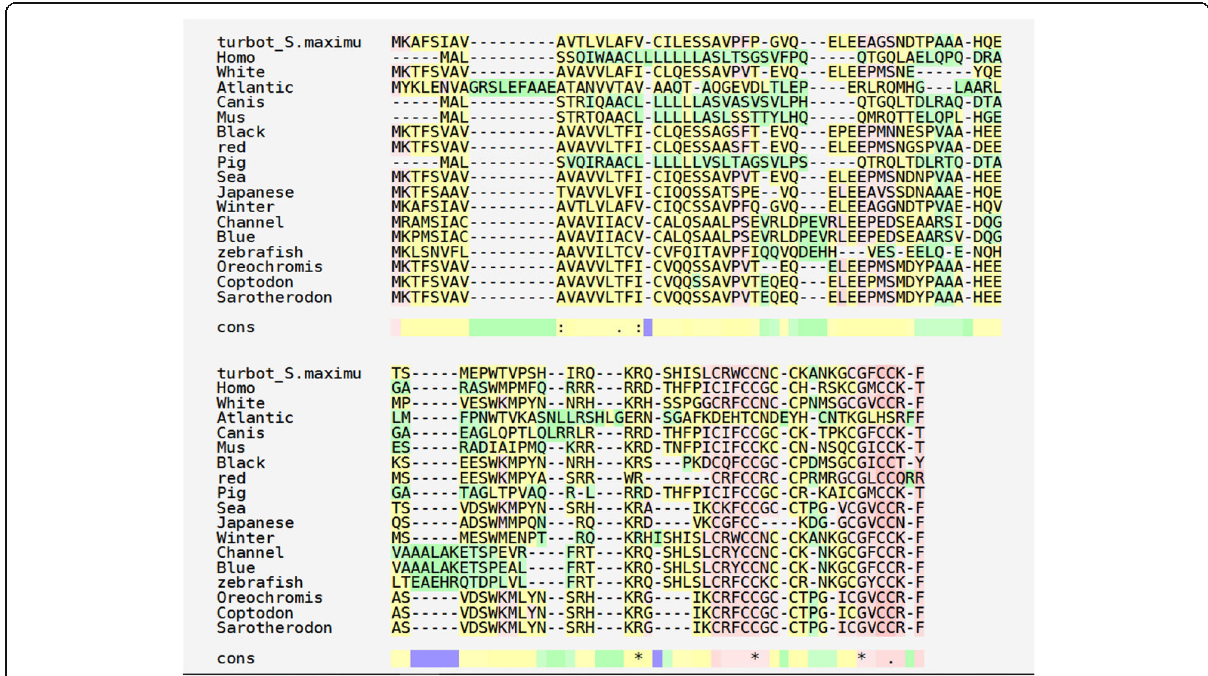
Fig. 4 Alignment of deduced amino acid sequences of O. niloticus , T. zillii , and S. galilaeus hepcidin 1 gene with those of turbot_S.maximus (AY994074), Homo sapiens (BC020612), white bass (AAM28440), Atlantic salmon (BI468191), Canis lupus familiaris (AY899807), Mus musculus